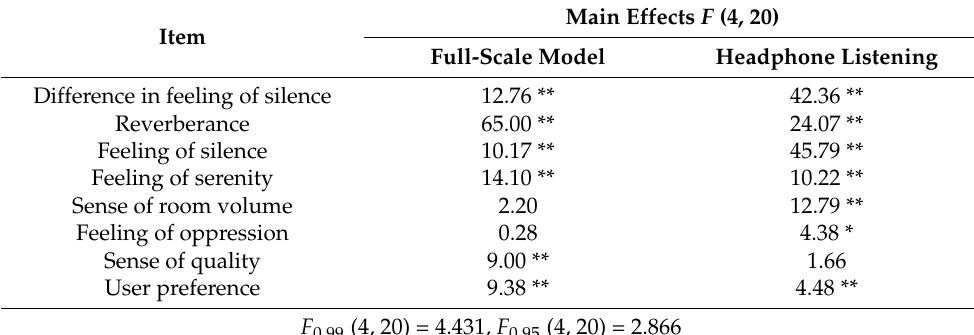
Table 4. Results of significant-difference tests of the main effects of the average absorption coefficient on the evaluation